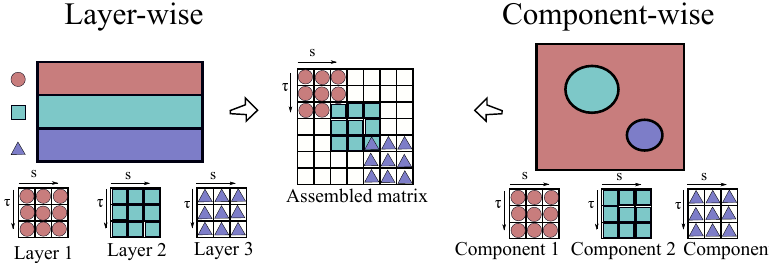
Figure 3. Layer-wise and component-wise assembly